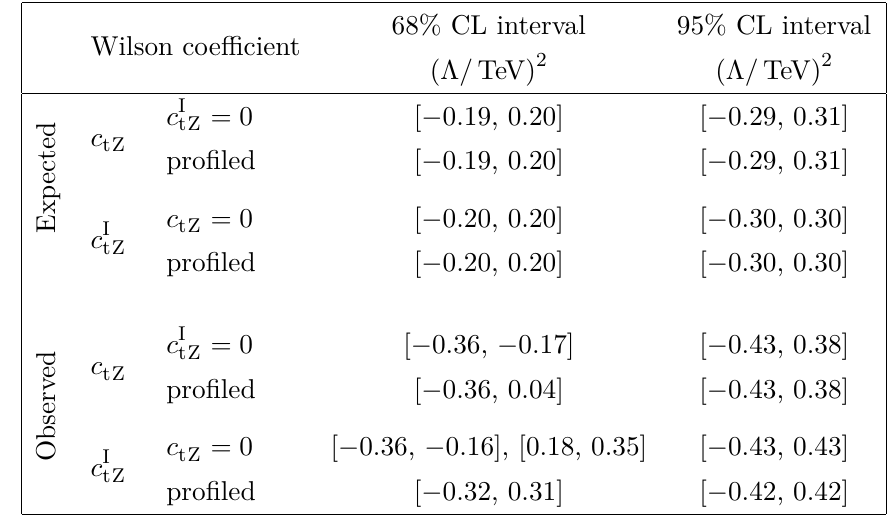
Table 8 . Summary of the one-dimensional intervals at 68 and 95%